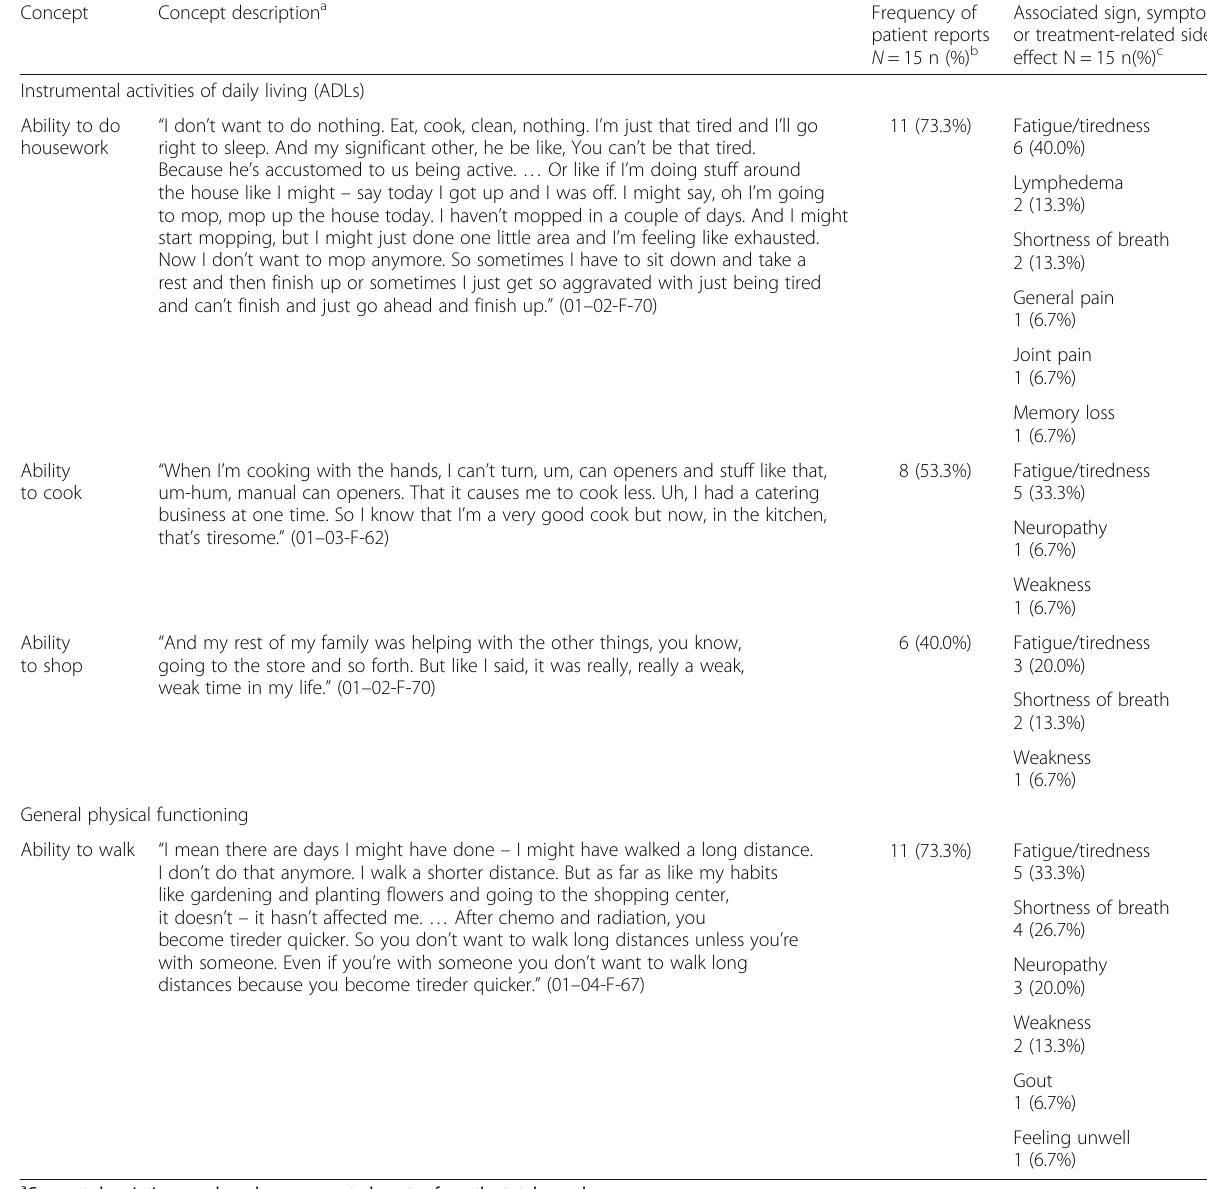
Table 4 Patient-reported HR+/HER2- advanced breast cancer physical function impact concept frequencies and descriptions reported by > 33.3% of